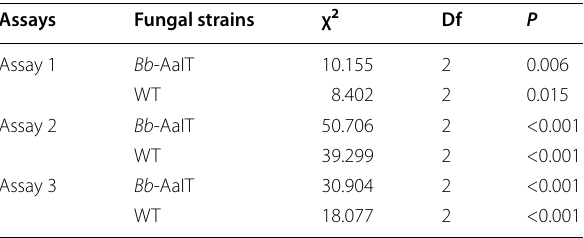
Table 1 Results of the log-rank test for the different con- centrations of Bb -AaIT or the WT against Aedes albopictus (larval or female adult mosquitoes) in assays 1–3